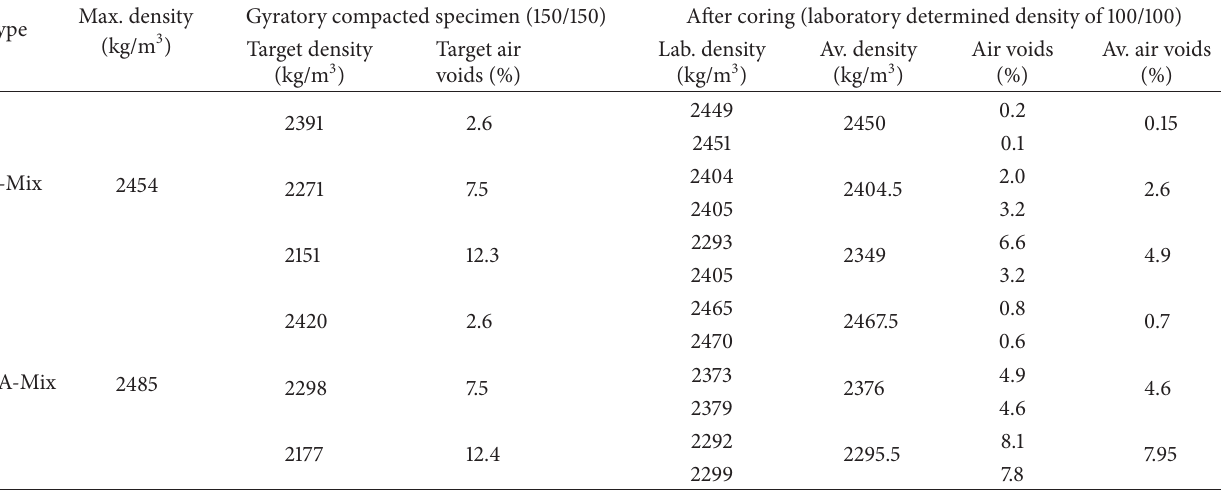
Table 5: Details density and air voids content for